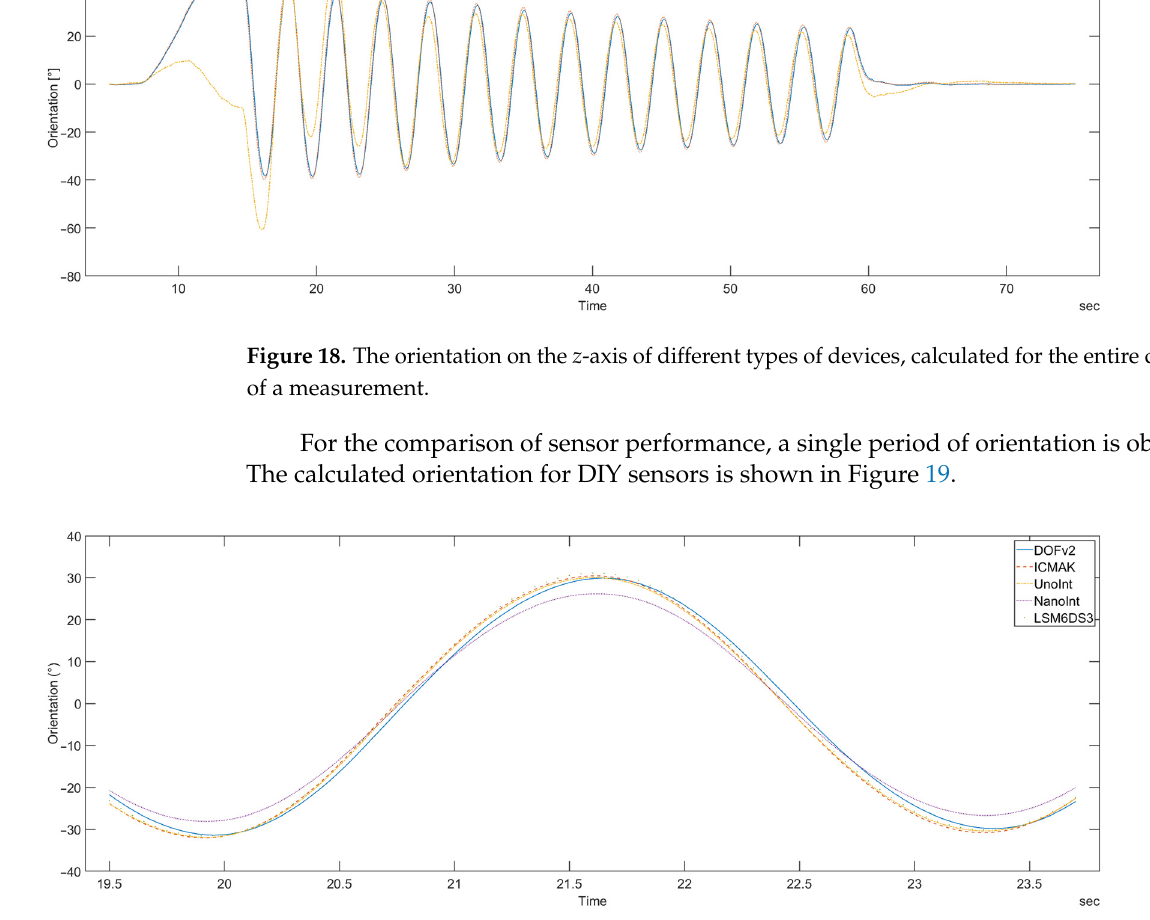
18 of 26 Figure 17. Acceleration on the z-axis ( left ), angular velocity on the x-axis ( center ), and orientation on the z-axis ( right ) obtained for five smartphones under test. Figure 17 shows the presence of glitches and spikes introduced by the measured smartphone devices into the accelerometer data. The gyroscope data are considerably smoother, but the A50 smartphone displays a time latency of around 500 ms compared to other devices. This latency is reflected in the calculated orientation.